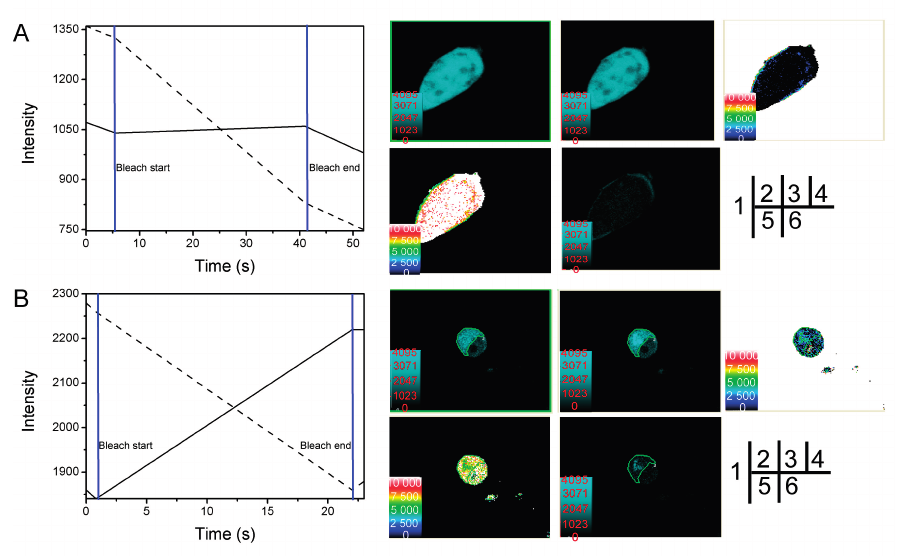
Figure 3. Verification of SelP' and α -tubulin interaction by the receptor photobleaching method of FRET. HEK293T cells were co-transfected with the empty plasmids pECFP-C1 and pEYFP-C1 as a negative control ( A ) or co-transfected with pECFP-C1- SelP' and pEYFP-C1- Tub for sample tests ( B ). (1) Photobleaching curves (solid lines for donor fluorescence and dashed lines for receptor fluorescence). The region of interest (ROI) was bleached at 515 nm; (2) The fluorescence images of donors before bleaching; (3) The fluorescence images of donors after bleaching; (4) Donor fluorescence increments before and after bleaching; (5) Diagram of the distance between donor and receptor; (6) FRET efficiency